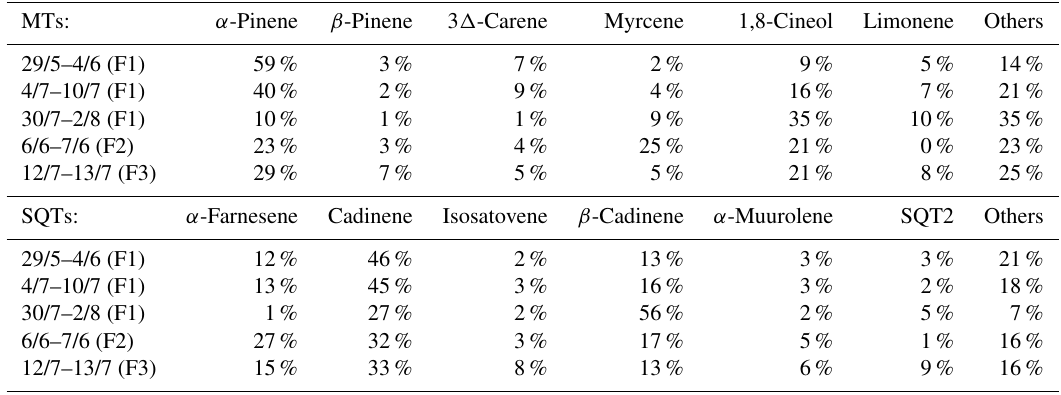
Table 2. The most abundant MTs and SQTs in the emissions at Lompolojänkkä fen during each measurement period. F1–3 indicates the measured frame.